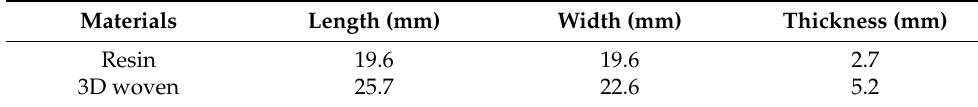
Figure 1. 3D woven composite. ( a ) 3D woven structure; ( b ) Cross section of weft tow; ( c ) Cross section of warp tow; ( d ) Specimen. Table 1. The dimensions of resin and 3D woven composite.